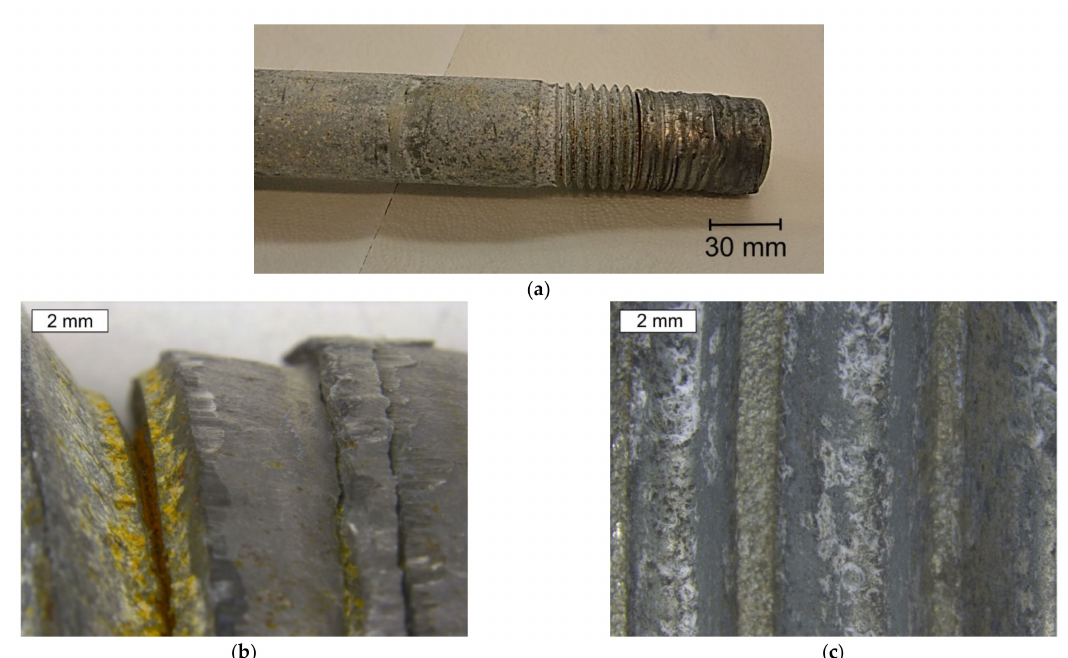
Figure 3. Sheared thread of the S1 bolt: ( a ) General view, ( b ) Cracks in the sheared thread roots, ( c ) Fretting damage of the